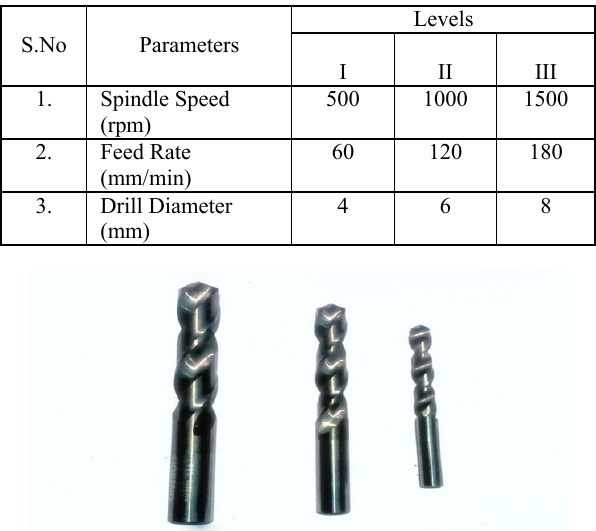
Table 1. Input Parameters and Values Considered